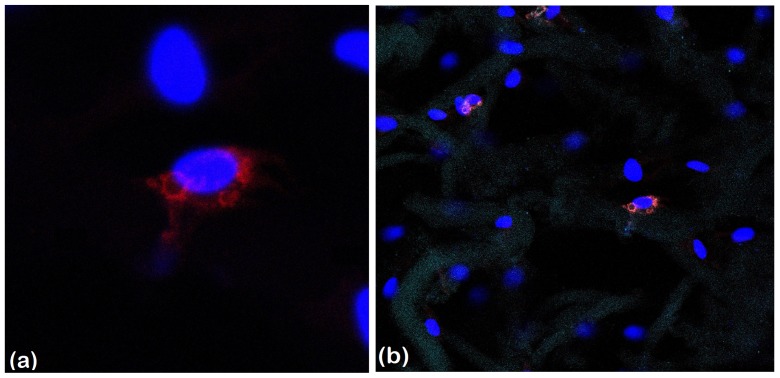
Confocal images revealing (a) perilipin distribution around the nucleus in a hADSC-Coll-SS construct exposed to adipogenic differentiation in vitro for 14 days and (b) hADSCs-Coll-SS construct after 14 days of adipogenesis triple stained for collagen type I (green), perilipin (red) and nuclei (blue).